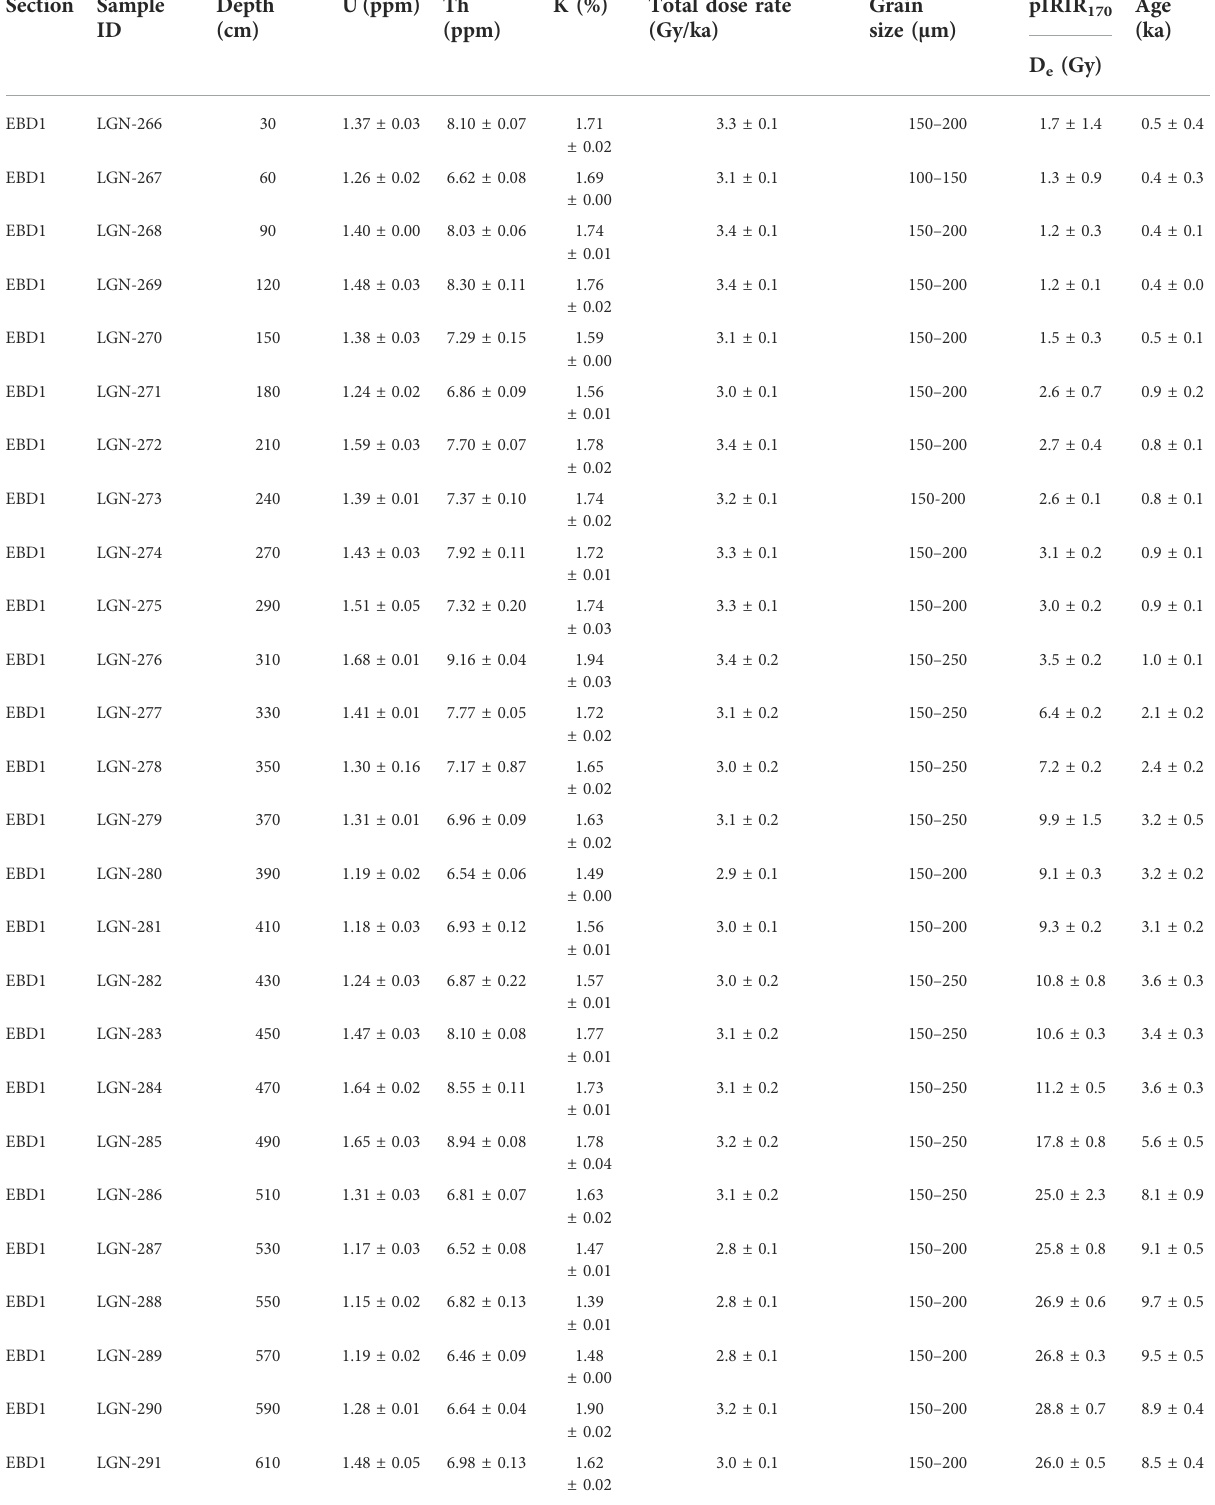
TABLE 1 Summary of the radionuclide concentrations, total dose rates, grain size, equivalent doses, and age results for 49 K-feldspar pIRIR 170 dates from EBD1 and EBD2. Section Sample